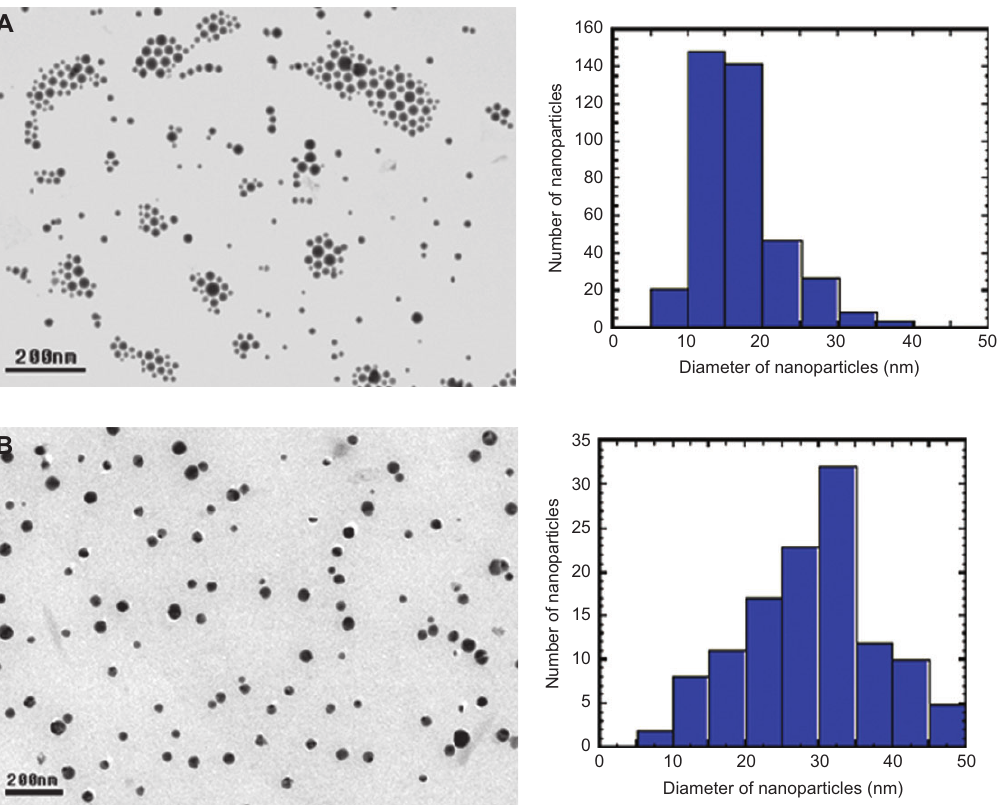
Figure 15 The TEM images (bright field) and size distributions of (A) the Field ’ s metal nanoparticles and (B) the indium nanoparticles, which were fabricated using the nanoemulsion method. The scale bars in both the TEM images represent 200